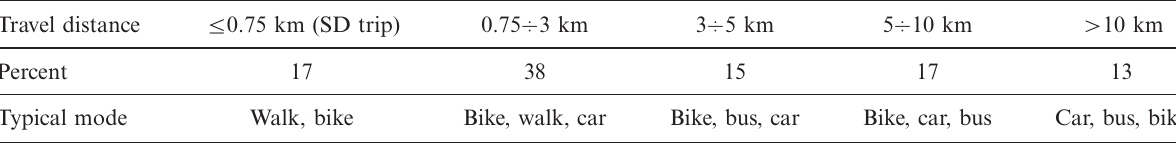
Table 4. Distance commute travel distance distribution